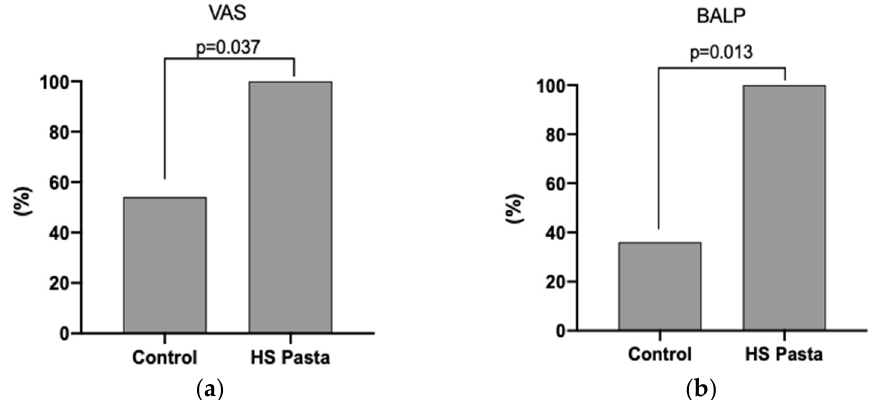
Figure 1. Prevalence of subjects who had a reduction in VAS value ( a ) and serum BALP concentration ( b ) after 6 weeks of treatment. A total of 18 participants were enrolled (control group n = 11, HS pasta n = 7, respectively). Abbreviation: VAS = visual analog scale; BALP = bone-specific alkaline phosphatase.